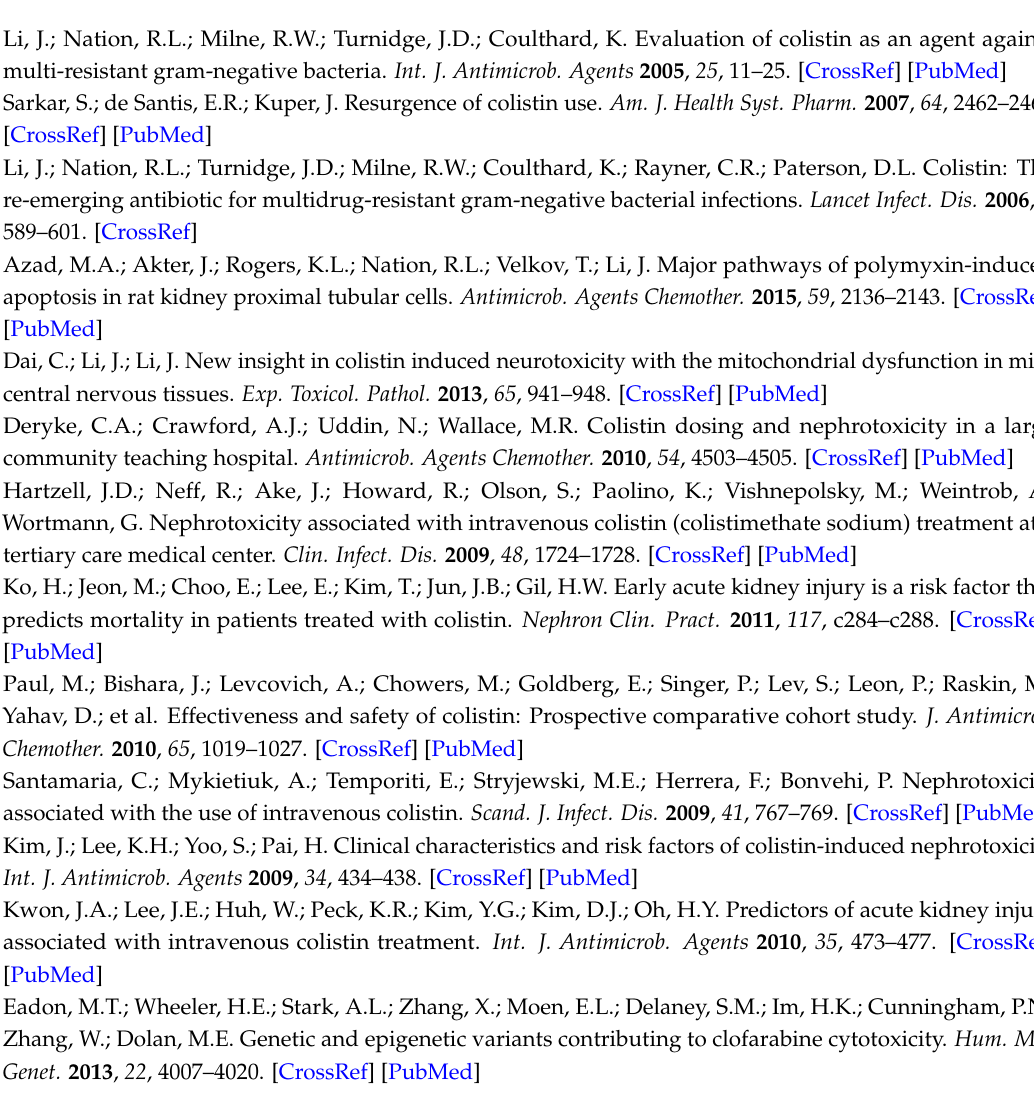
Figure S1: Histogram illustrating the distribution of cytotoxicity phenotypes in LCLs; Figure S2: Additional association study results; Table S1: SNPs associated with colistin cytotoxicity; Table S2: pQTLs associated with colistin cytotoxicity; Table S3: Associations between colistin cytotoxicity and protein expression; Table S4: LCLs used in each analysis; Table S5: Primer sequences and